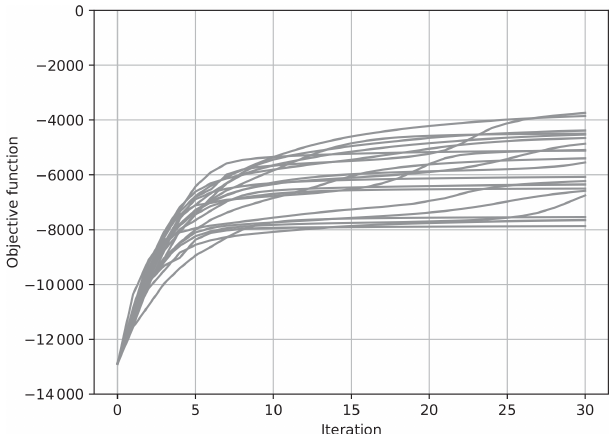
Figure 2. The value of the objective function J for each iteration for 20 trials of the estimation. The ensemble was updated using Eq. (32) with δ = 1 . 5 × 10 − 2